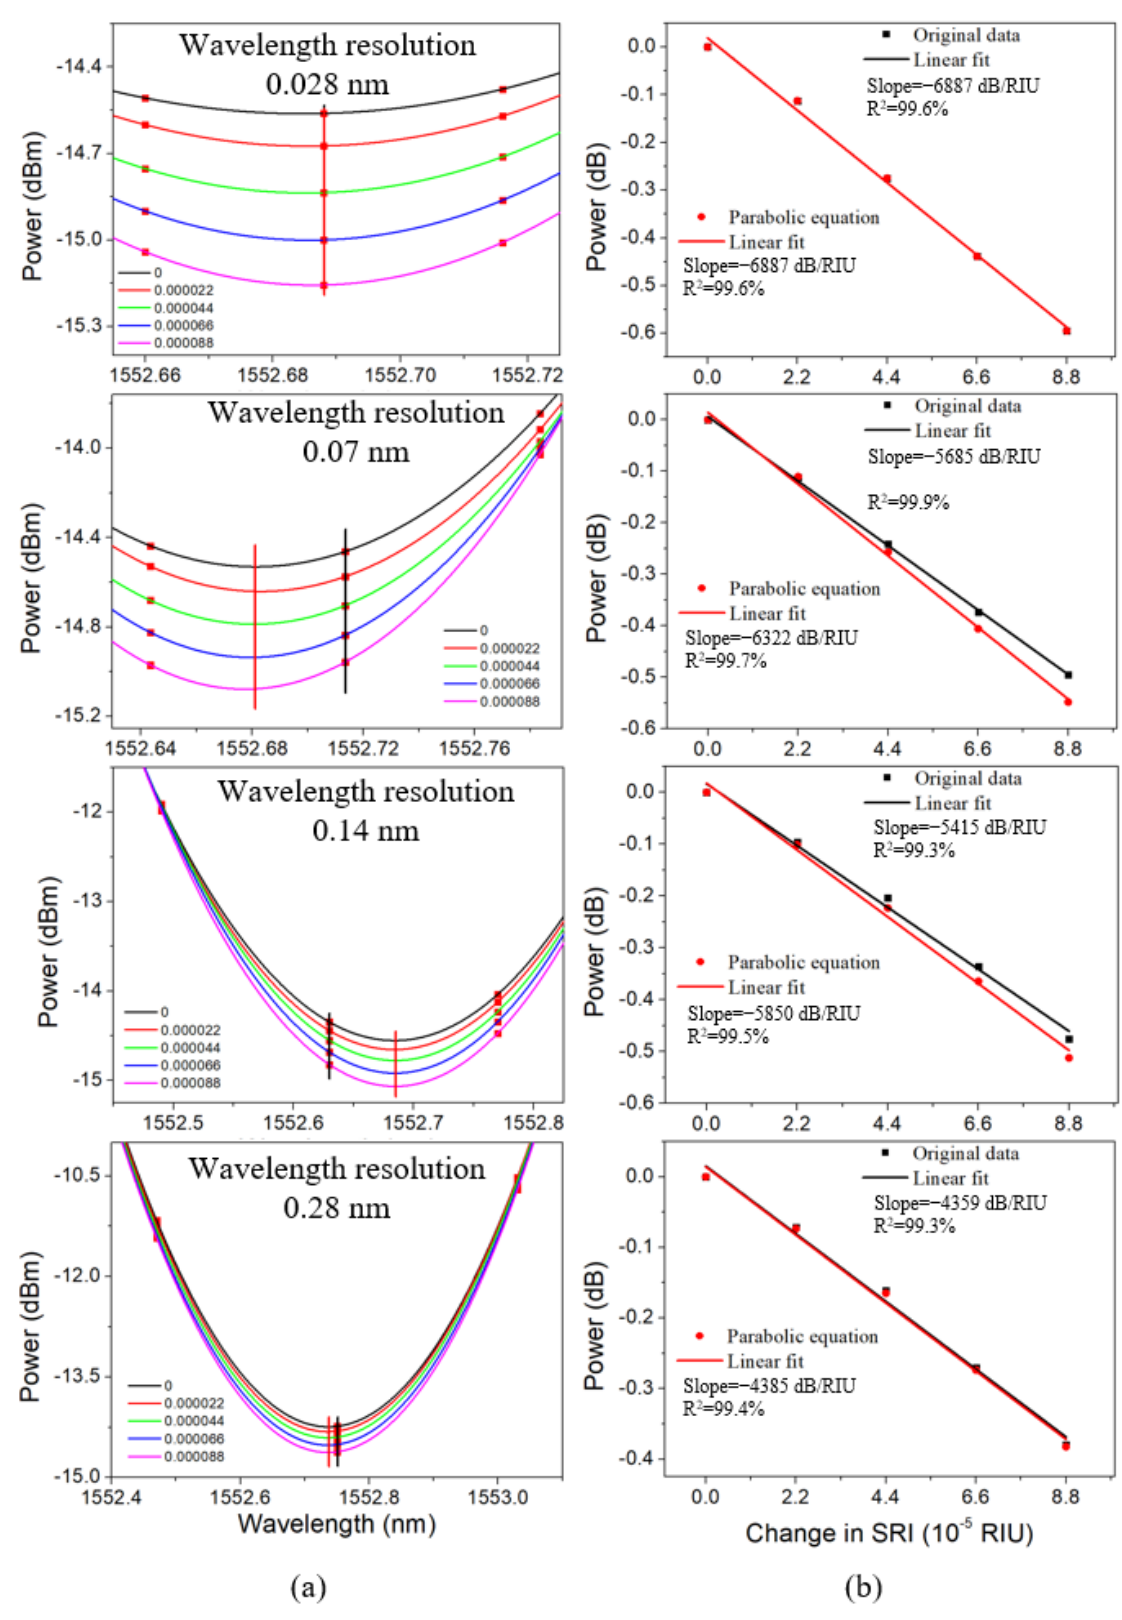
Figure 8. Transmitted amplitude spectra of the cladding mode No. 10 ( a ) and linear fit of the cladding mode amplitude ( b ) with three original data and parabola calculated based on these data, respectively, in different glucose aqueous solutions (refractive index ~1.3573).